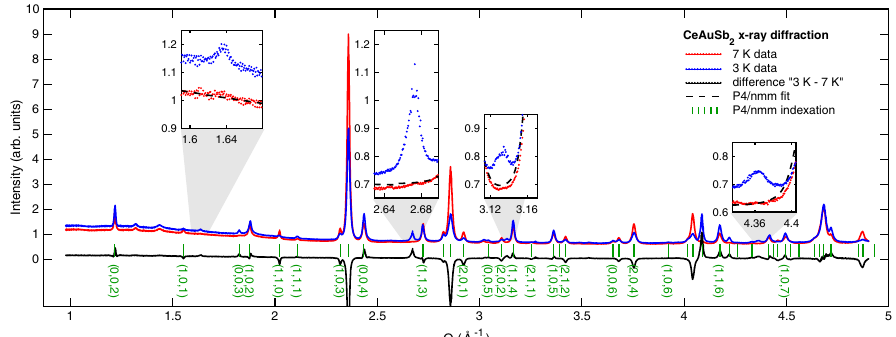
FIG. 2. Synchrotron (20 keV) x-ray powder diffraction patterns of CeAuSb 2 obtained above (7 K, red) and below (3 K, blue) the transitions at T . The difference pattern (black line) emphasizes significant intensity gains, or losses, at most Bragg positions. Green N; nem markers and labels indicate the indexation of these peaks in the high-temperature P 4 =nmm structure. A lattice distortion is not resolved. Below the structural transition, four additional Bragg peaks are observed (see insets), which are not indexed by the parent